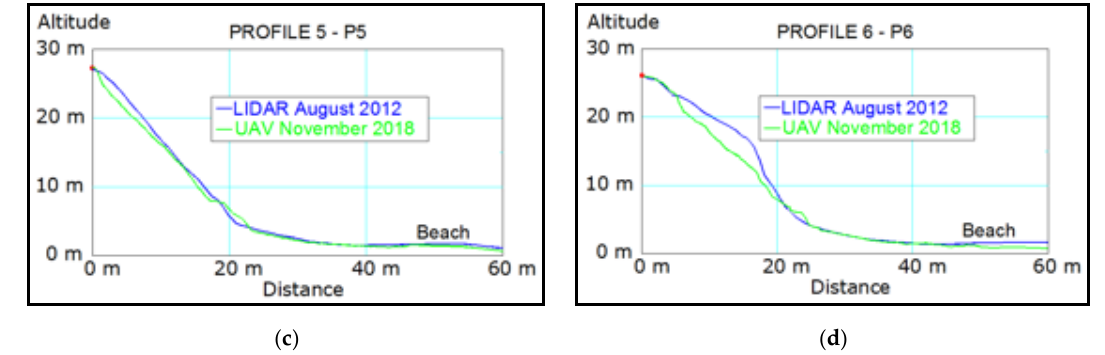
Figure 7. ( a ) Cartography light, detection, and ranging (LiDAR) (National Geographic Institute (IGN)) (August 2012); ( b ) Height contours from DEM of UAV (November 2018); ( c ) Comparison of Profile 5 from LiDAR and from UAV; ( d ) Comparison of Profile 6 from LiDAR and UAV.